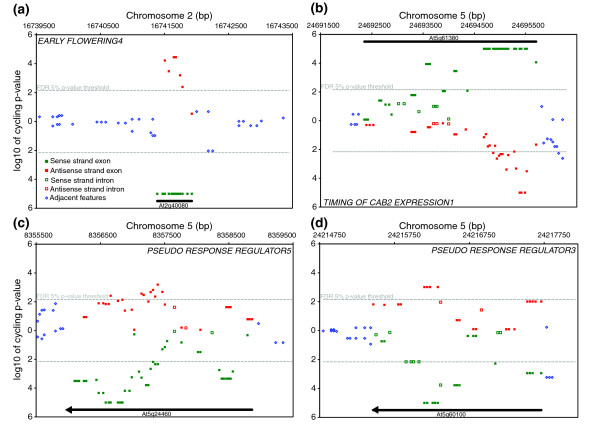
The Arabidopsis tiling arrays portray several interesting classes of circadian behavior in the genome. Each symbol is a feature on the tilling array showing location in the genome (x-axis) and significance of the spectral analysis (y-axis) for (a) EARLY FLOWERING4, (b) TIMING OF CAB2 EXPRESSION1, (c) PSEUDO RESPONSE REGULATOR5, and (d) PSEUDO RESPONSE REGULATOR3. The top half of each panel displays the Watson strand and the bottom half the Crick strand. Individual features that exceed the false discovery rate 5% p-value threshold (-) are considered to have a circadian rhythm.